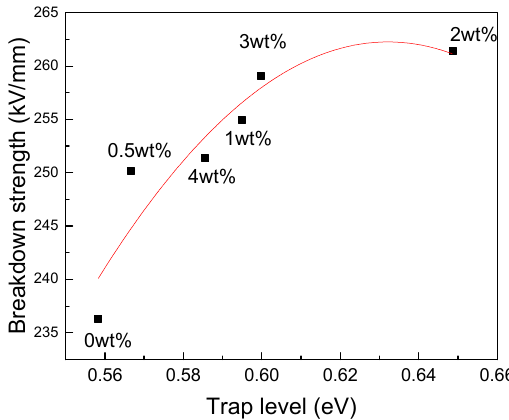
Figure 15. Relationship between breakdown strength and trap level.